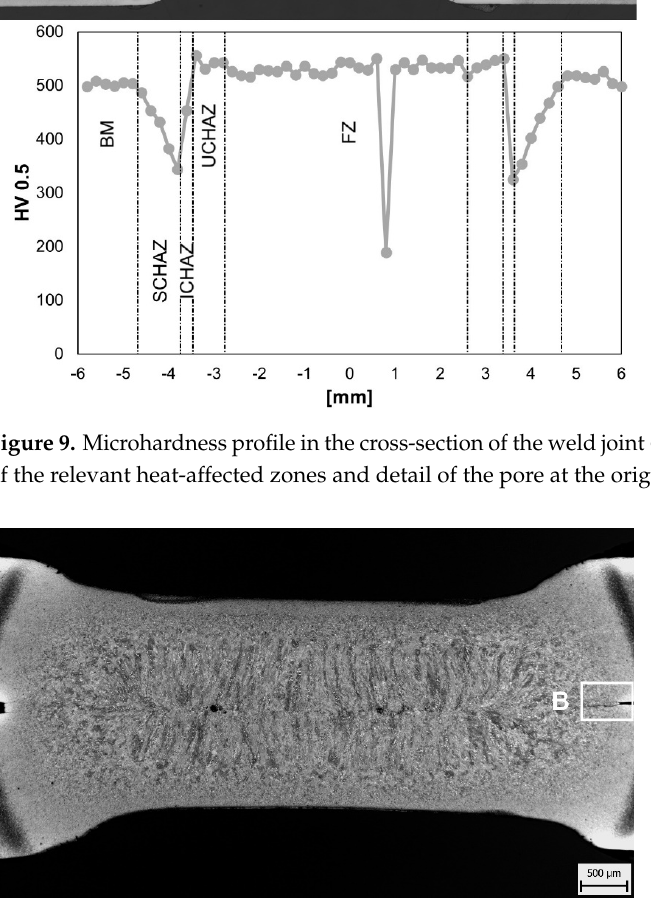
Figure 10. Cross ‐ sectional view of the welded Zn ‐ coated sample (7 kA) with a marked area, B, of Figure 10. Cross-sectional view of the welded Zn-coated sample (7 kA) with a marked area, B, of SEM ‐ EDS analysis of the weld notch. SEM-EDS analysis of the weld